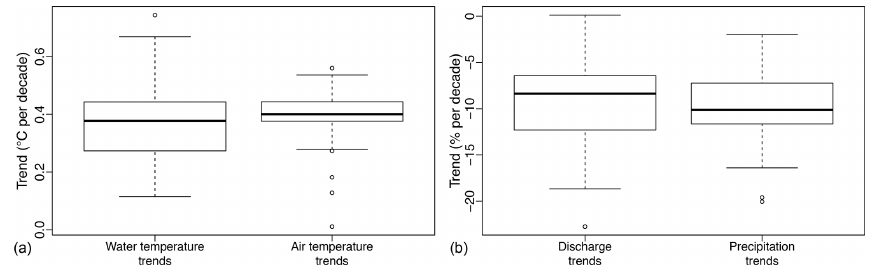
Figure 5. Water and air temperature trends (a) as well as normalized discharge and normalized precipitation trends (b) for the 1999– 2018 period and for the 52 catchments described in Table 1 and their associated meteorological